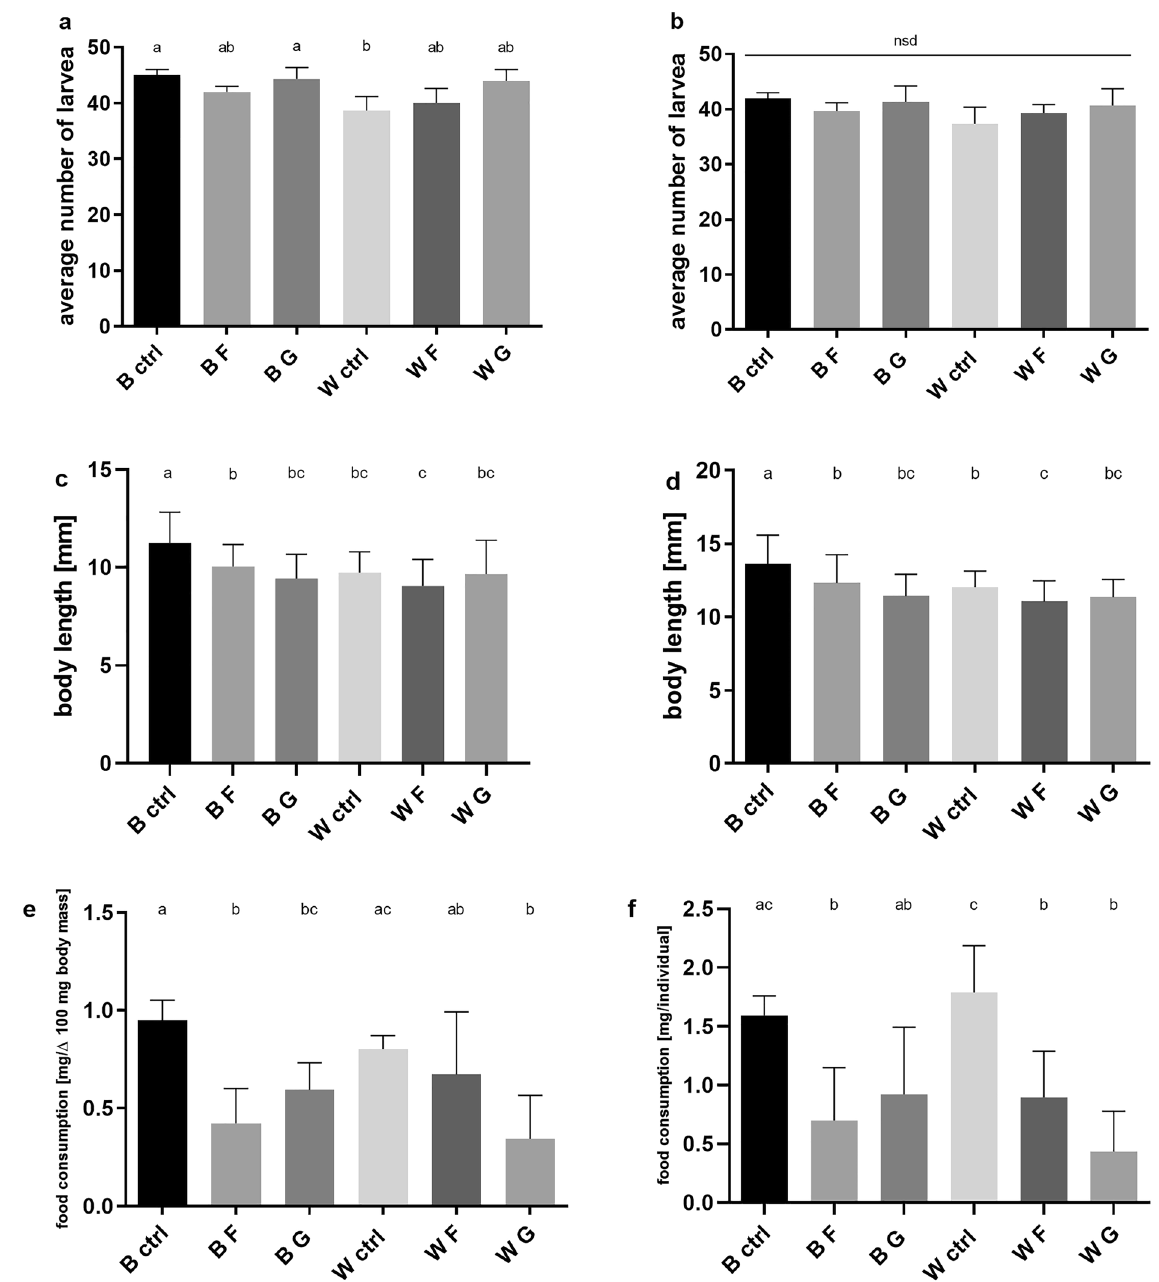
Figure. 2. Effects of HMD on larvae mortality, body length and food consumption ( B black-eyed strain, W white-eyed strain, CTRL control group, F fructose, G glucose). Average (mean ± SD, n = 4) larvae number in two time points: ( a ) 30th (ANOVA F (5, 12) = 5.003, P = 0.0105) and ( b ) 40th day after hatching (ANOVA F (5, 12) = 1.529, P = 0.2529). Tukey’s multiple comparisons test, P < 0.05. Average larvae body length (mean ± SD, n = 4) in two time points: ( c ) 30th (Brown-Forsythe ANOVA test, F = 13.67 (5, 234.9), P < 0.0001) and ( d ) 40th day (Brown-Forsythe ANOVA test, F = 16.33 (5, 222.0), P < 0.0001) after hatching. Dunnett’s T3 multiple comparisons test, P < 0.05. Average (mean ± SD, n = 6) food consumption expressed as ( e ) amount of eaten food per 100 mg of increased body mass (ANOVA F (5, 30) = 8.575, P < 0.0001) by crickets larvae between 30–35 day of development and ( f ) the amount of eaten food per individual (ANOVA F (5, 30) = 10.07, P < 0.0001). Different letters denote groups differing significantly. Tukey’s multiple comparisons test, P <